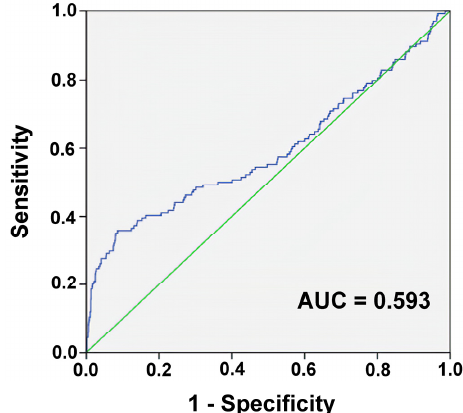
Figure 2. Receiver operating characteristic curves and area under the curve (AUC) of the delta De Ritis ratio for predicting the mortality of the adult trauma patients with moderate-to-severe traumatic brain injuries.